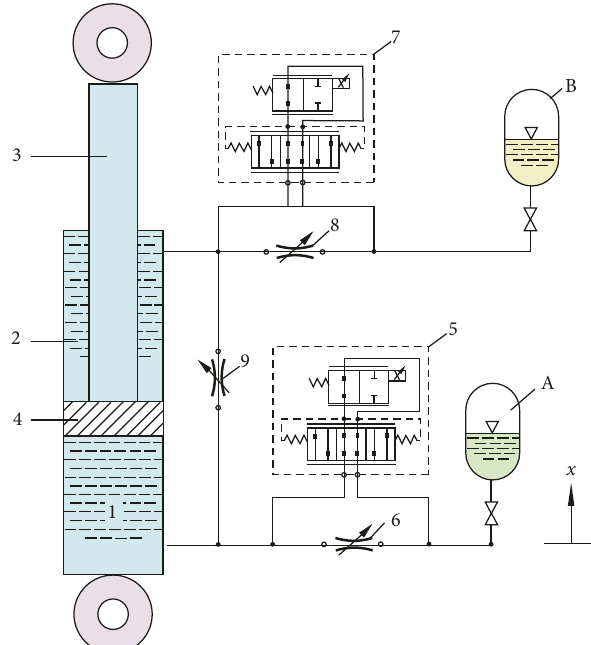
Figure 4: Model of front axle hydropneumatic